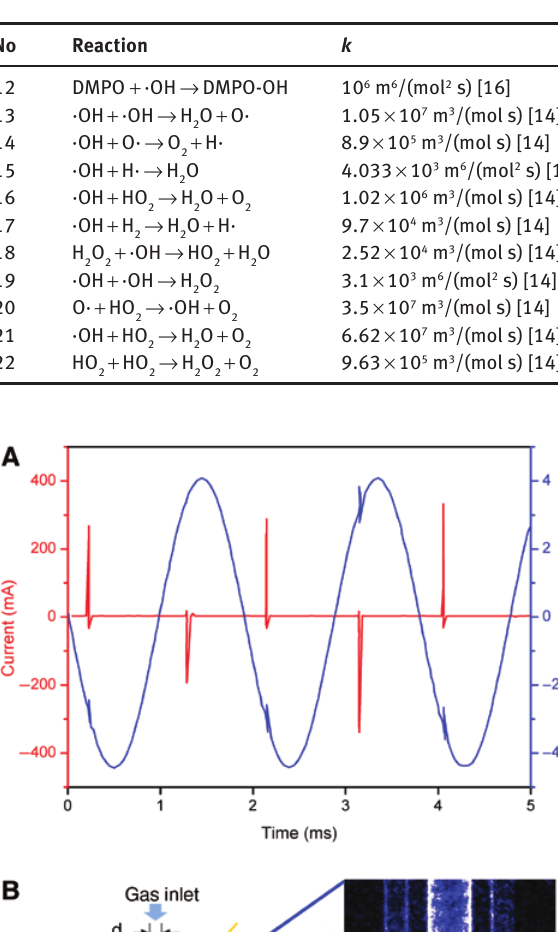
Table 2: Dominant reactions in the liquid phase.